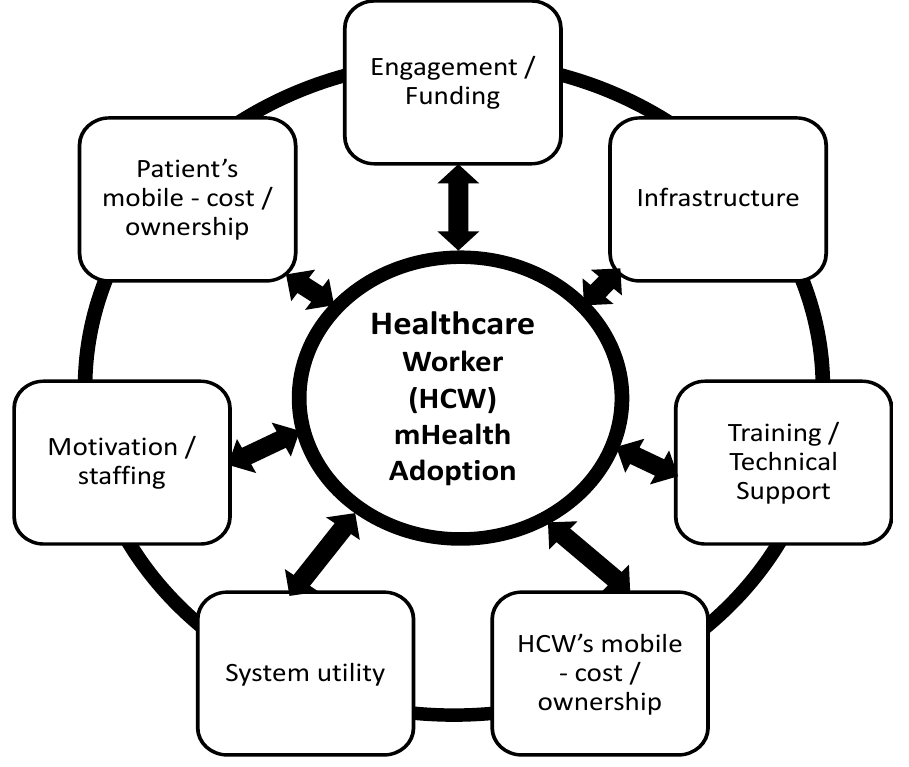
Figure 2. Proposed conceptual framework for successful adoption of mHealth by healthcare workers in the developing world.